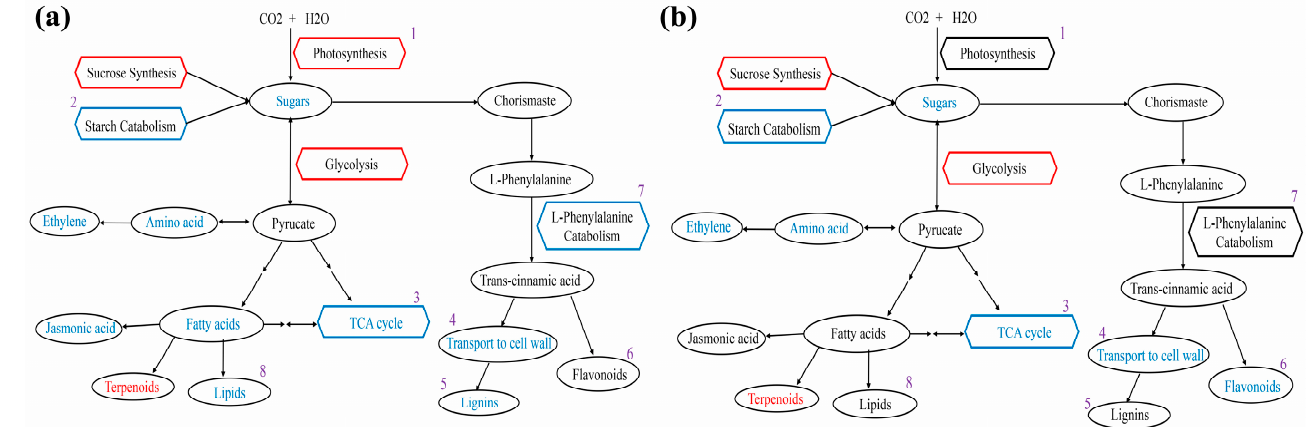
Figure 10. Analysis of transcriptomic-metabolomic data between GFabV-infected and GFabV-free in leaves. ( a ) Overview of the major changes in response to GFabV in ‘Summer Black’ at EL15. Ovals and hexagons represent metabolites and pathways, respectively. Red represents down-regulated genes and metabolites, whereas blue represents up-regulated genes and metabolites. The numbers (1–8) represent the pathways analyzed on the basis of Tables S8, S14, and S22. ( b ) Overview of the major changes in response to GFabV in ‘Summer Black’ at EL31. The numbers (1–8) represent the pathways analyzed on the basis of Tables S9, S14, and S23.